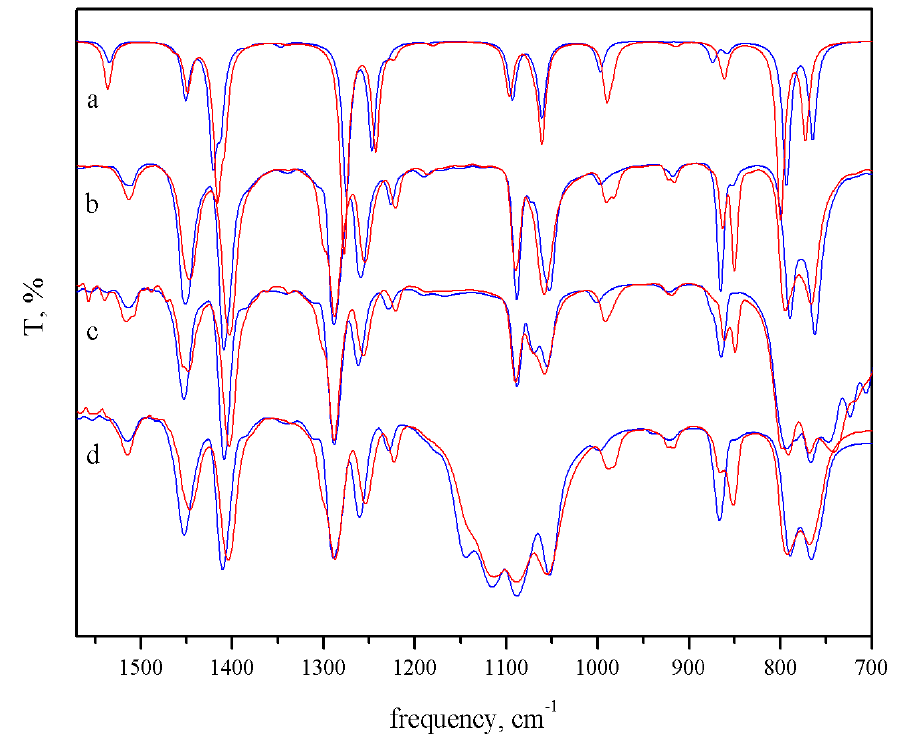
Figure 3. Influence of the metal spin state on the IR spectra of Fe(II) complexes with tris(pyrazol-1-yl)methane: ( a )—B3LYP [Fe(HC(pz) 3 ) 2 ] 2 + ; ( b )—[Fe(HC(pz) 3 ) 2 ]I 2 ; ( c )—[Fe(HC(pz) 3 ) 2 ]SiF 6 ; ( d )—[Fe(HC(pz) 3 ) 2 ](ClO 4 ) 2 ; the blue line indicates LS state; the red line shows HS state.